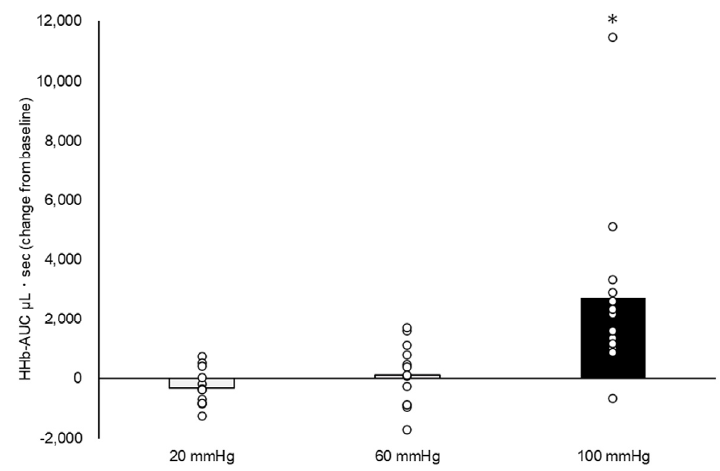
Figure 5. Area under the curve of deoxygenated hemoglobin (HHb-AUC) for the three occlusion pressures. White dots indicate the data for each participant. There was a significant increase in the HHb-AUC for the 100 mmHg pressure compared with the 20 mmHg and 60 mmHg (*) pressures ( p < 0.05). Between-group differences were evaluated using a Bonferroni post hoc test.